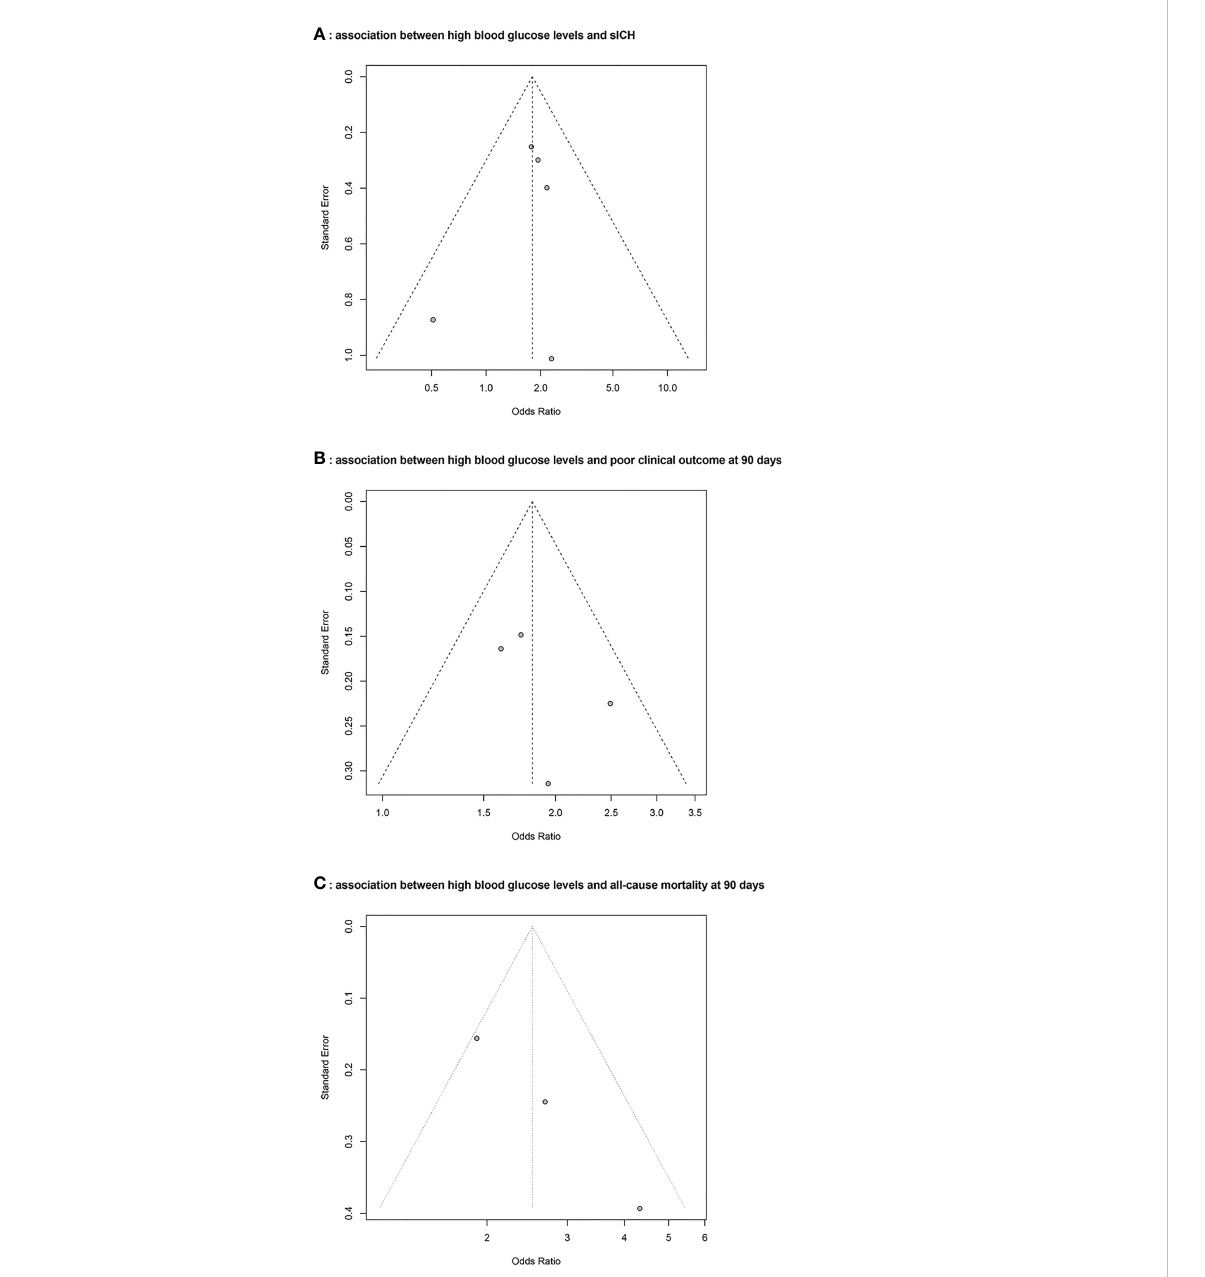
FIGURE 4 Funnel plots for the publication bias underlying the meta-analyses. (A) : Association between hyperglycemia and symptomatic intracranial hemorrhage (sICH) (B) : Association between hyperglycemia and poor clinical outcome at 90 days (C) : Association between hyperglycemia and all- cause mortality at 90